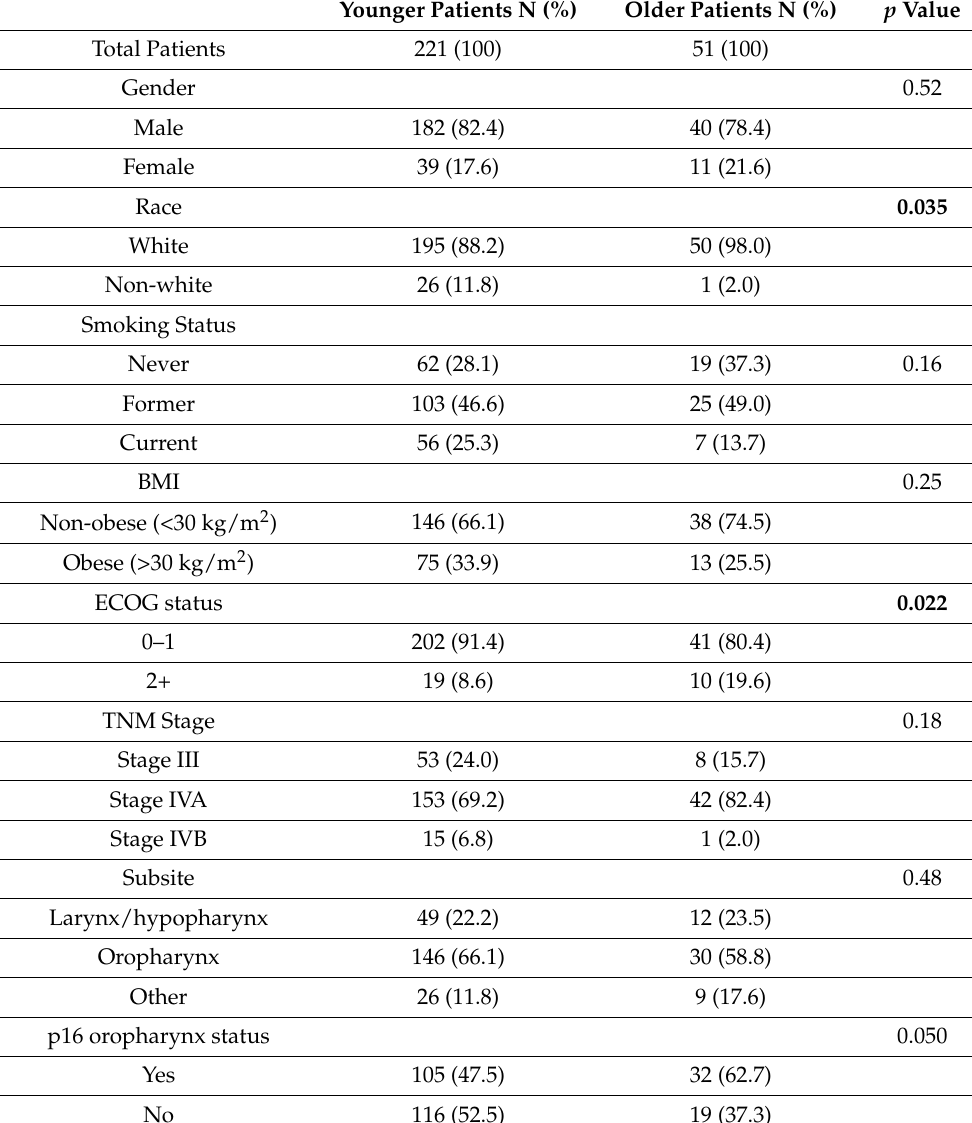
Table 1. Patient population characteristics stratified by younger (<70 years old) and older age groups ( ≥ 70 years old). Bolded variables represent p -value <